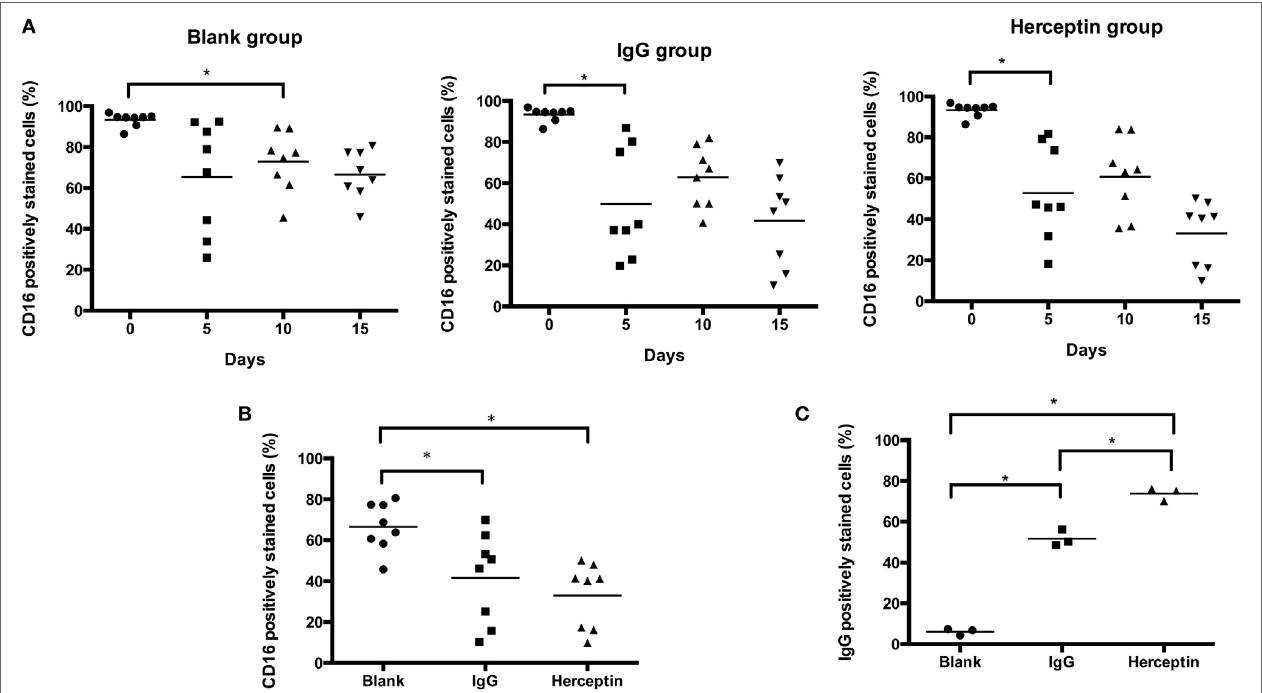
FigUre 5 | CD16 and Herceptin levels on expanded natural killer (NK) cells among the final expansion products cultured under three different conditions. Expression in gated CD3 − CD56 + NK cells was analyzed by flow cytometry (FCM). (a) Changes in the expression of CD16 at 0, 5, 10, and 15 days. (B) Comparison of CD16 expression at 15 days between the final expanded NK cells in each of the three groups. (c) Amounts of Herceptin and IgG1 remaining on the NK cell surface at Day 15. We used a secondary antibody to detect Herceptin and IgG1 on the NK cells in the final products using FCM. The results shown in (a,B) are presented as the means of eight patients and the results shown in (c) are presented as the means of three patients. Error bars represent the SD. * p <